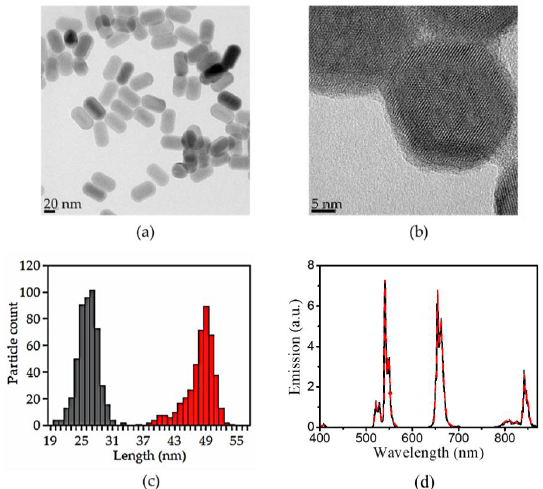
Figure 1. Representative HRTEM images of ( a ) UC n and, ( b ) UC@CB[7] nanoparticles. ( c ) Histogram showing the size distribution of the NPs for the width (grey bars) and length (red bars). ( d ) Corrected emission spectra (λ ex = 975 nm) of 10 mg/mL DMSO dispersions of ligand-free UCNPs (black line) and UC@CB[7] (red dotted line).